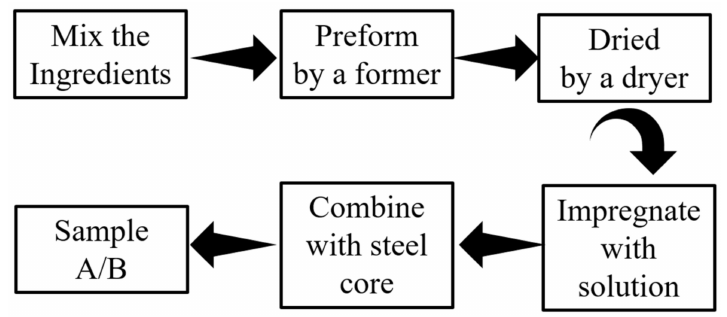
Figure 2. Manufacturing process of sample A/B.